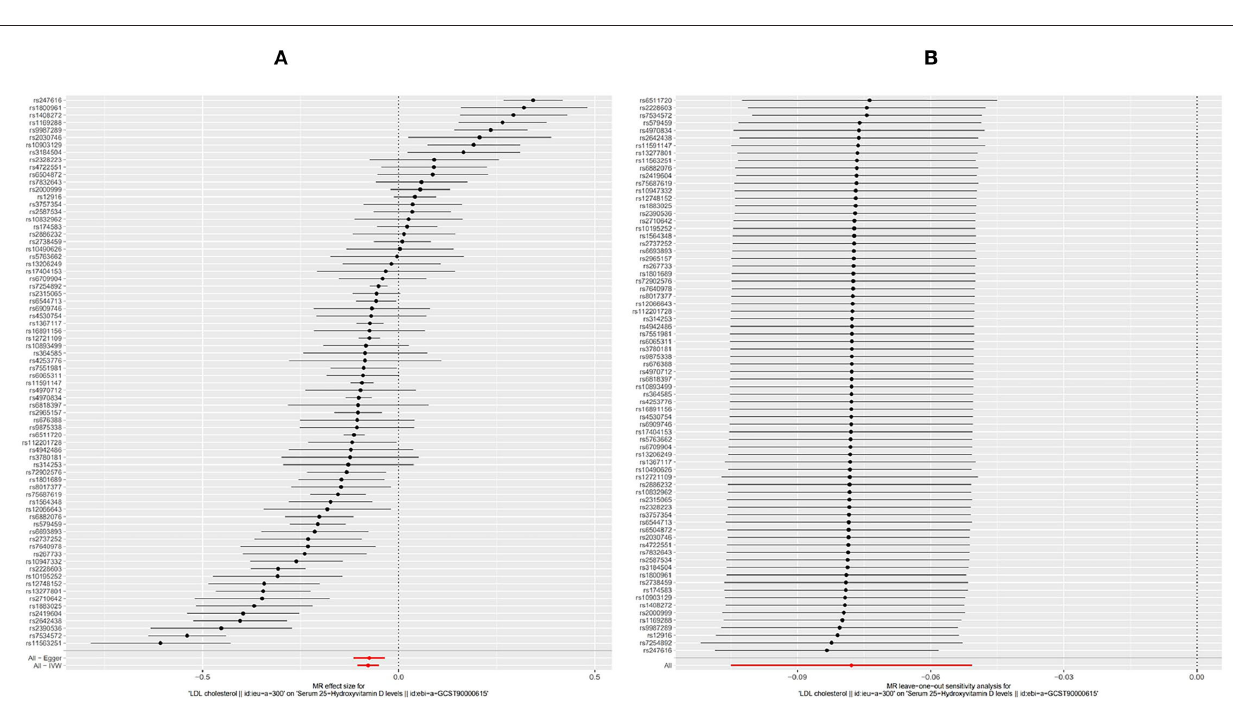
FIGURE 4 | Forest plot of included SNPs in the mendelian randomization analysis for casual effect of low-density lipoprotein (LDL) on vitamin D deficiency. (A) Meta-analysis of SNPs’ effects on vitamin D deficiency based on inverse variance weighted (IVW) method with random effect model. (B) Sensitivity analysis by omitting every SNP. LDL, Low-density